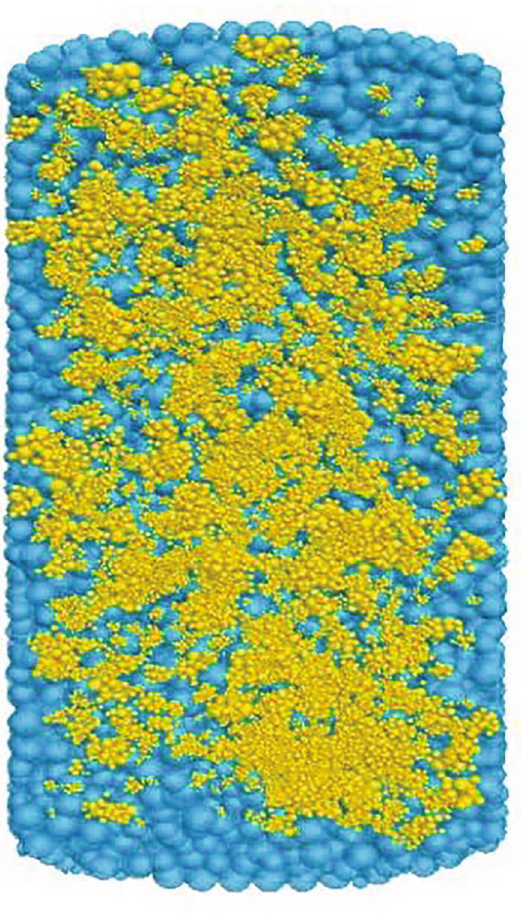
Figure 4: Particle crushing